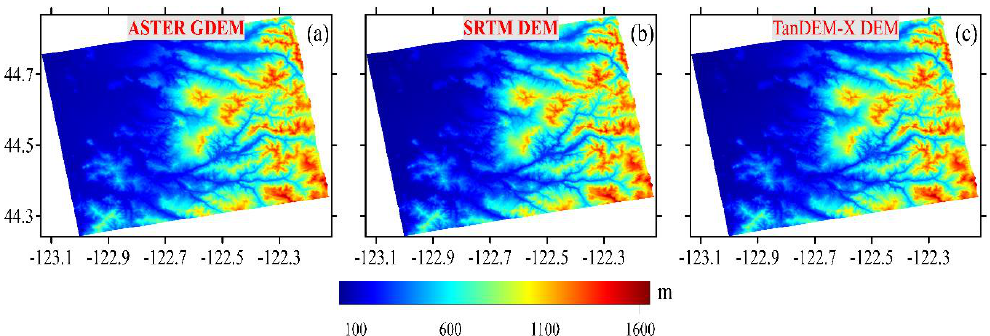
Figure 8. ( a ) ASTER GDEM. ( b ) SRTM DEM. ( c ) TanDEM-X DEM.